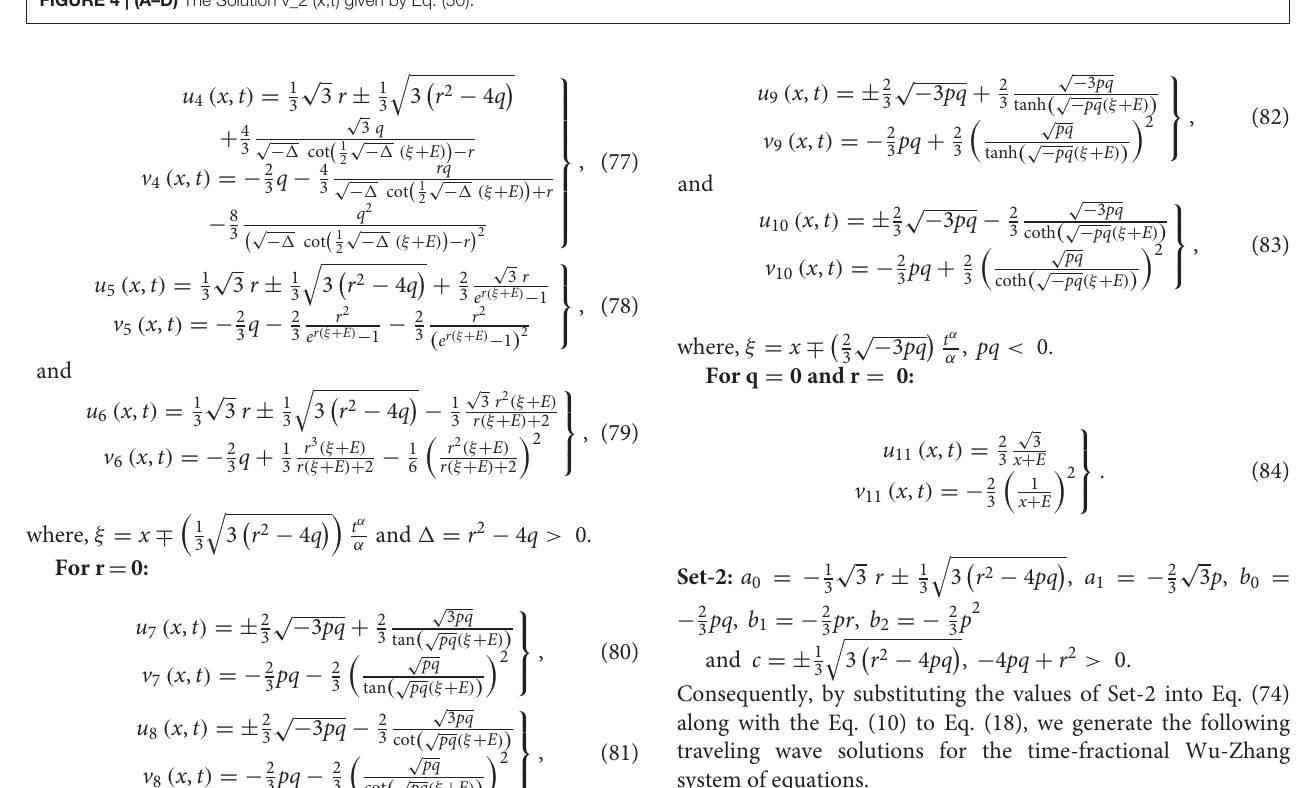
FIGURE 4 | (A–D) The Solution v_2 (x,t) given by Eq. (50).